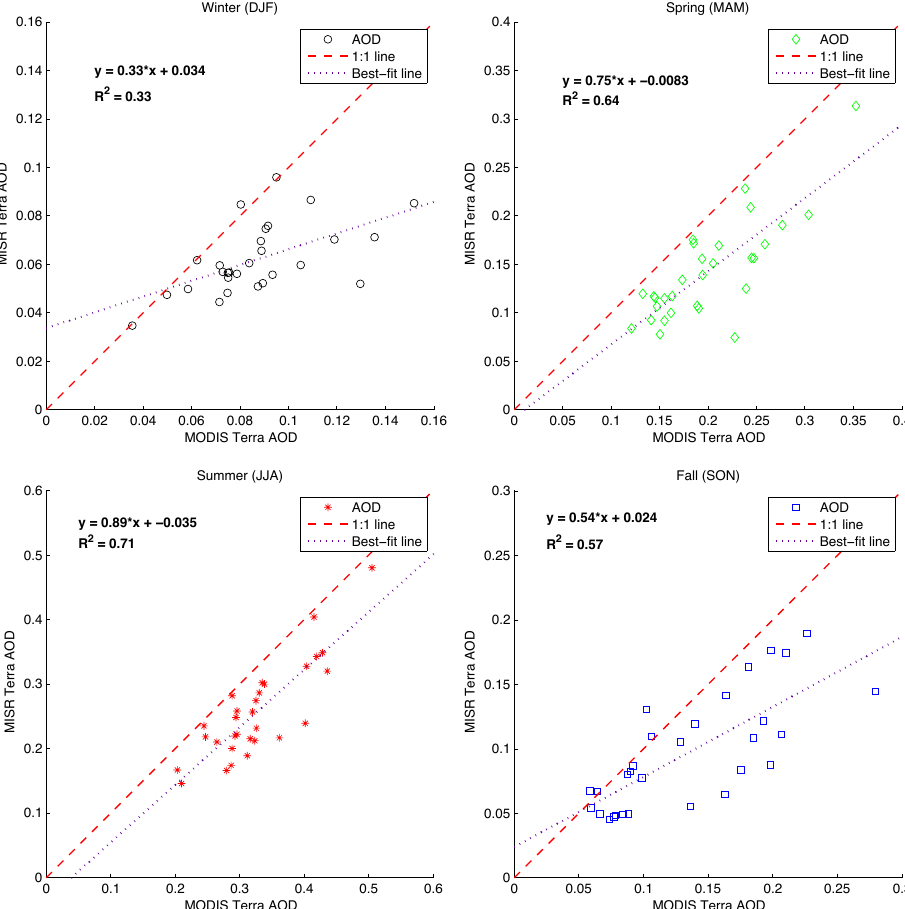
Fig. 4. Seasonal scatterplots of MODIS Terra AOD vs. MISR Terra AOD. Red dashed line denotes 1:1. Purple dotted line denotes linear regression